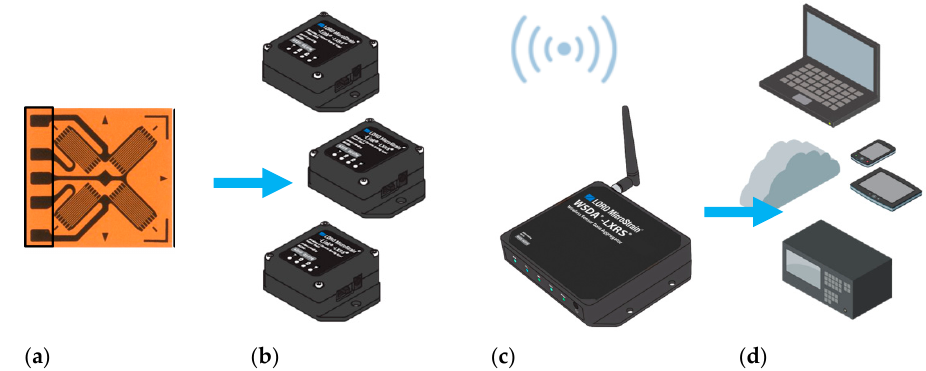
Figure 4. Diagram of the measurement system [13]: ( a ) strain gauge in a full-bridge configuration as a sensor, ( b ) wireless nodes, ( c ) gateway, ( d ) software.